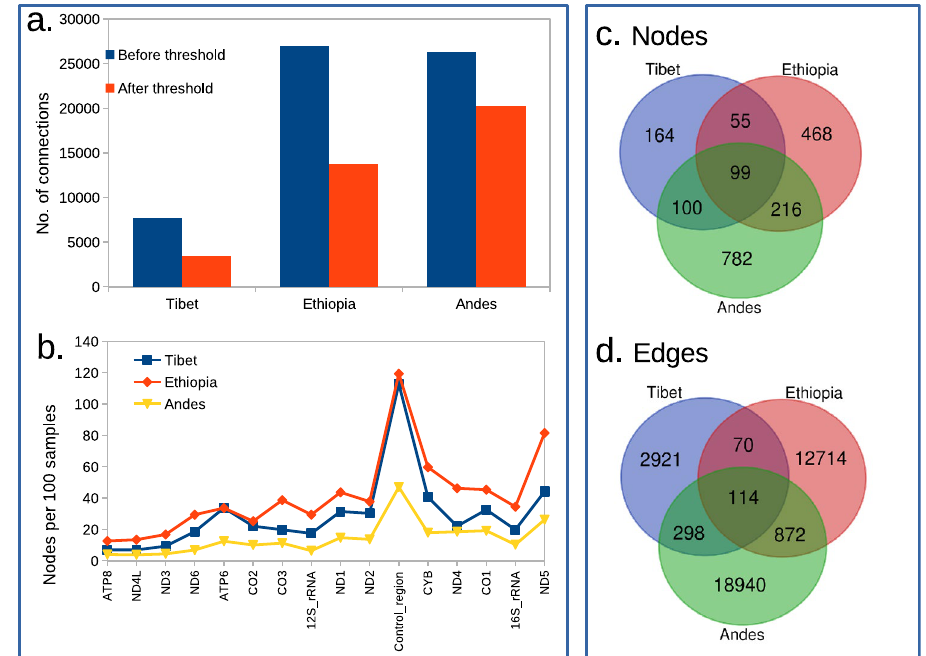
their lengths on x-axis. Note that t-RNA genes are not shown. ( c ) Distribution of nodes and ( d ) co-mutation pairs across all the three